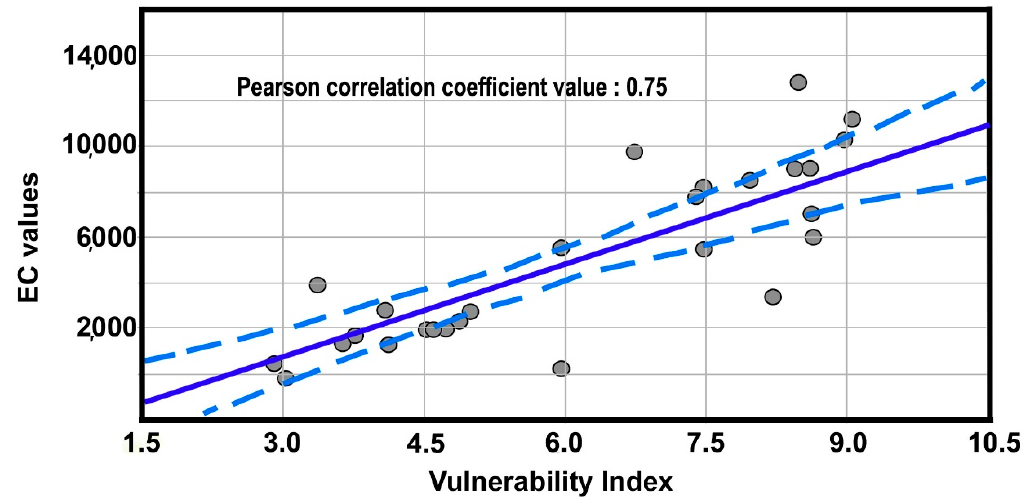
Figure 5. Correlation between the GALDIT vulnerability index and EC values for the study area.